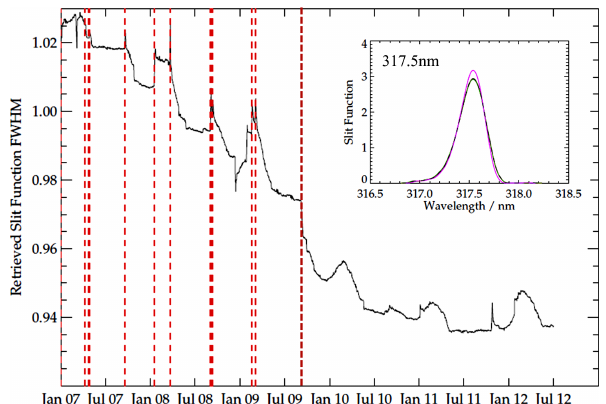
Figure 1. Variation with time of retrieved scaling factor for nominal FWHM of slit function (black solid). Red dashed lines indicate dis- continuities associated with various in-orbit operations, including the second (and last) throughput test in September 2009. The inset panel shows an example of how the effective shape of the measured slit function is modified for the pixel centred at 317.5nm, where the black line indicates start of operations (January 2007) and the pink line is the shape in January